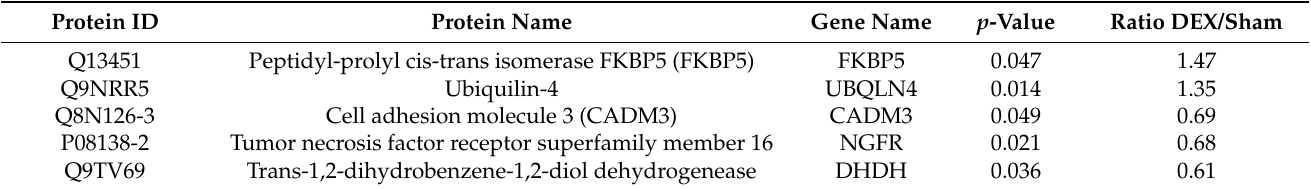
Table 1. Regulated proteins following dexamethasone (DEX) intervention in experimental CRVO. Protein